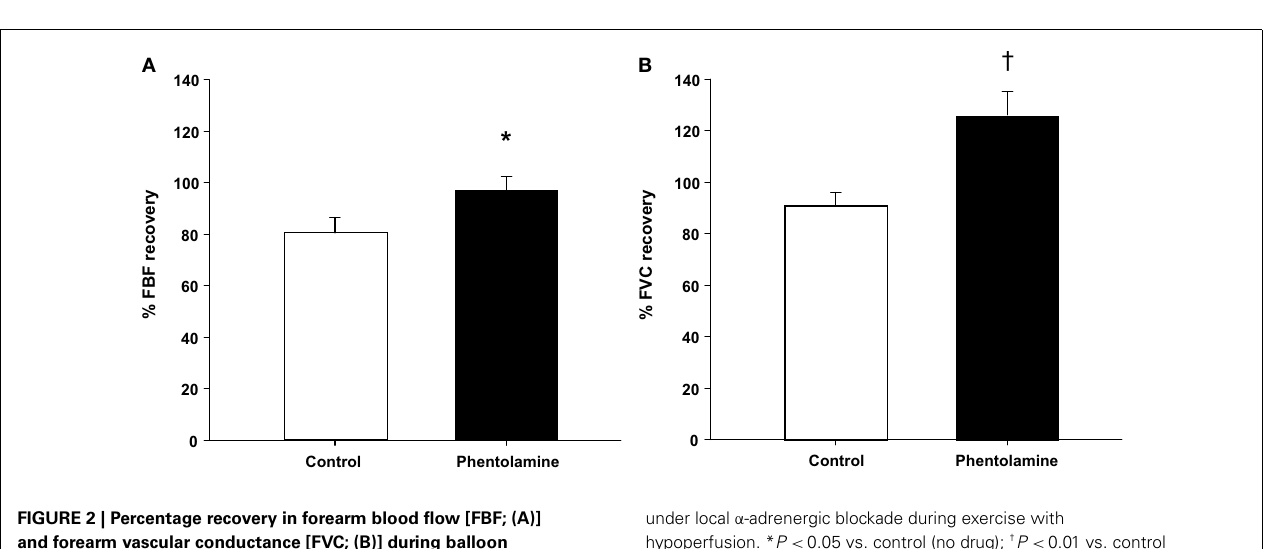
under local α -adrenergic blockade during exercise with hypoperfusion. * P < 0.05 vs. control (no drug); † P < 0.01 vs. control (no